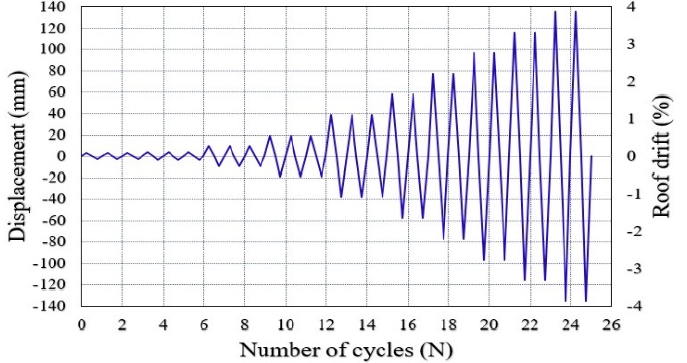
Figure 5. Applied load